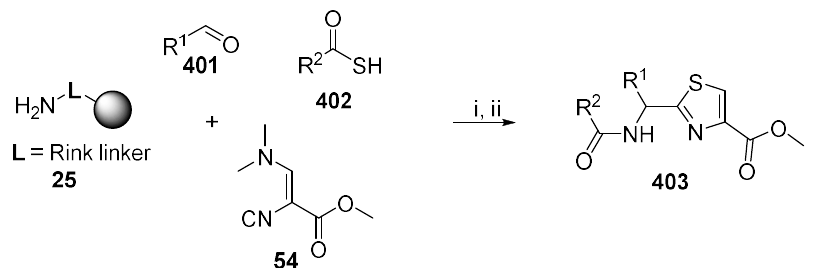
Scheme 67. Synthesis of thiazoles on Rink amide resin.